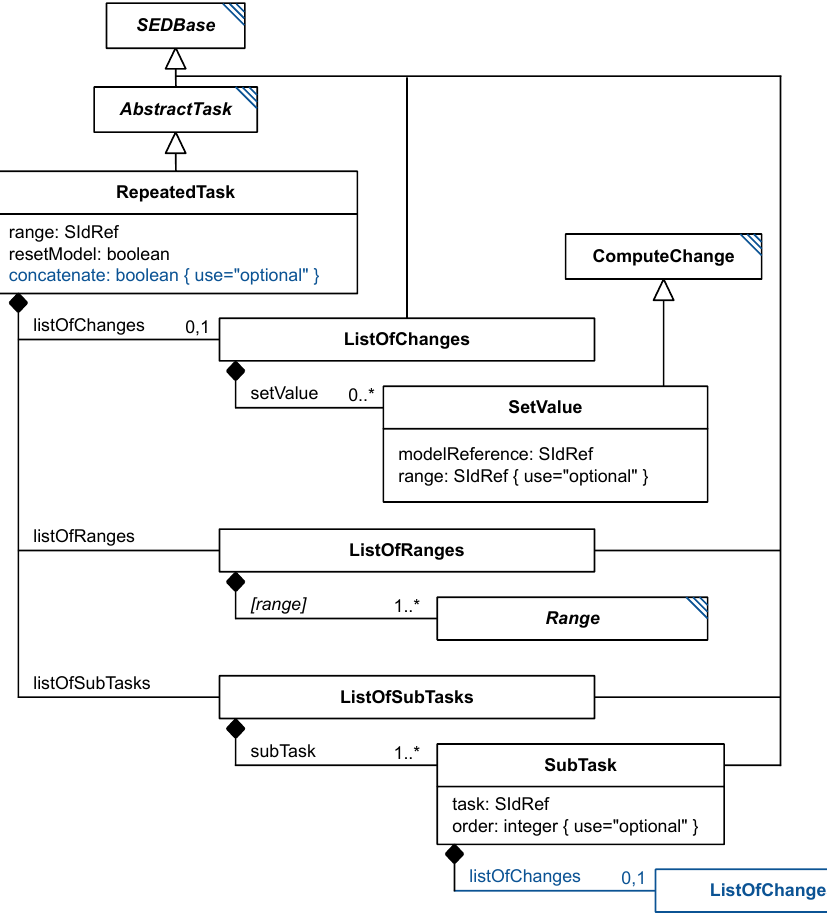
Figure 2.13: The SED-ML RepeatedTask